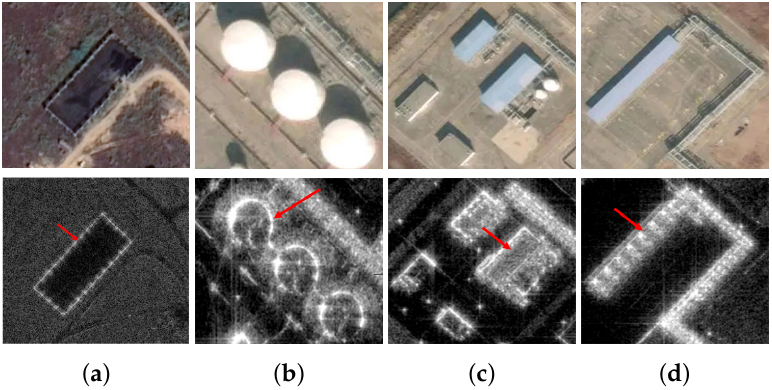
Figure 6. Optical images of four man-made targets and corresponding SAR images: (from left to right) ( a ) The optical image and SAR image of warehouses; ( b ) The optical image and SAR image of tanks; ( c ) The optical image and SAR image of buildings; ( d ) The optical image and SAR image of special